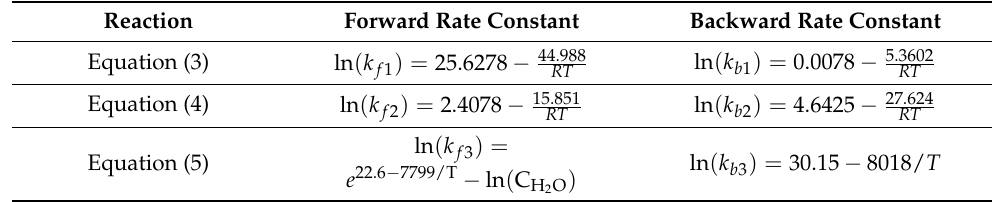
Table 1. Forward and backward